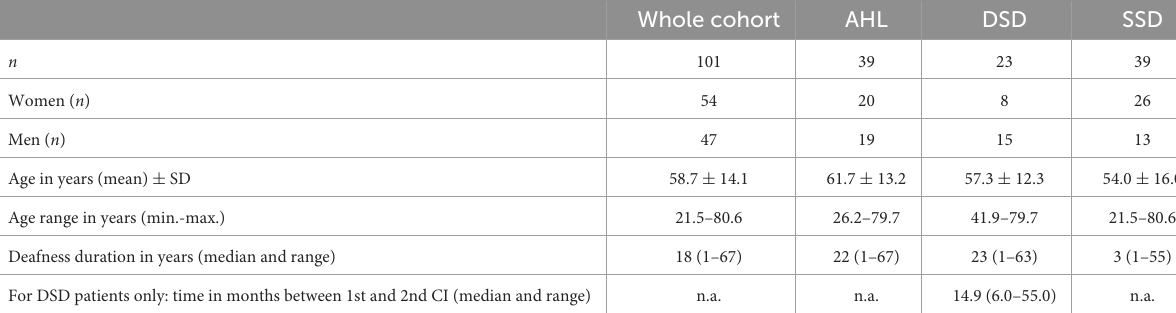
TABLE 1 Descriptive statistics of the